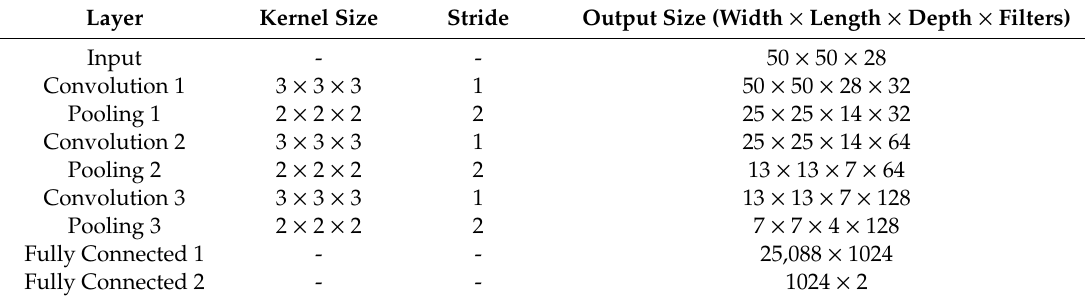
Table 2. Model architecture of the 3-dimensional convolutional neural networks (3D CNN) used in this